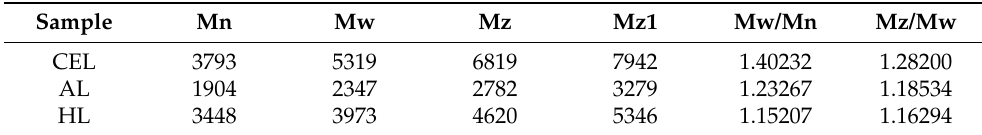
Table 1. Molecular weight of alkaline and hydrothermal